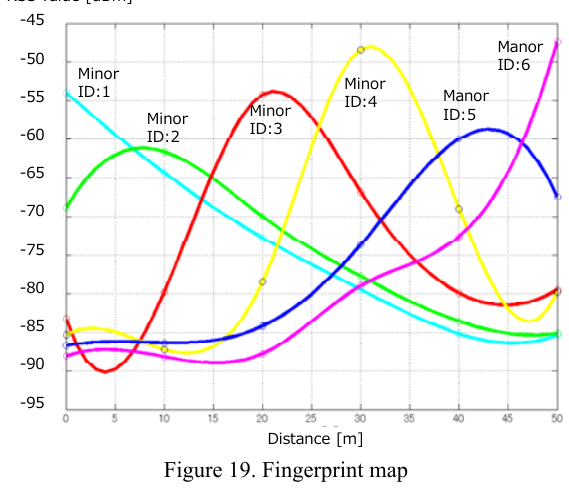
Figure 17. Estimated distances from iBeacon transmitters to the iBeacon receiver in the second experiment